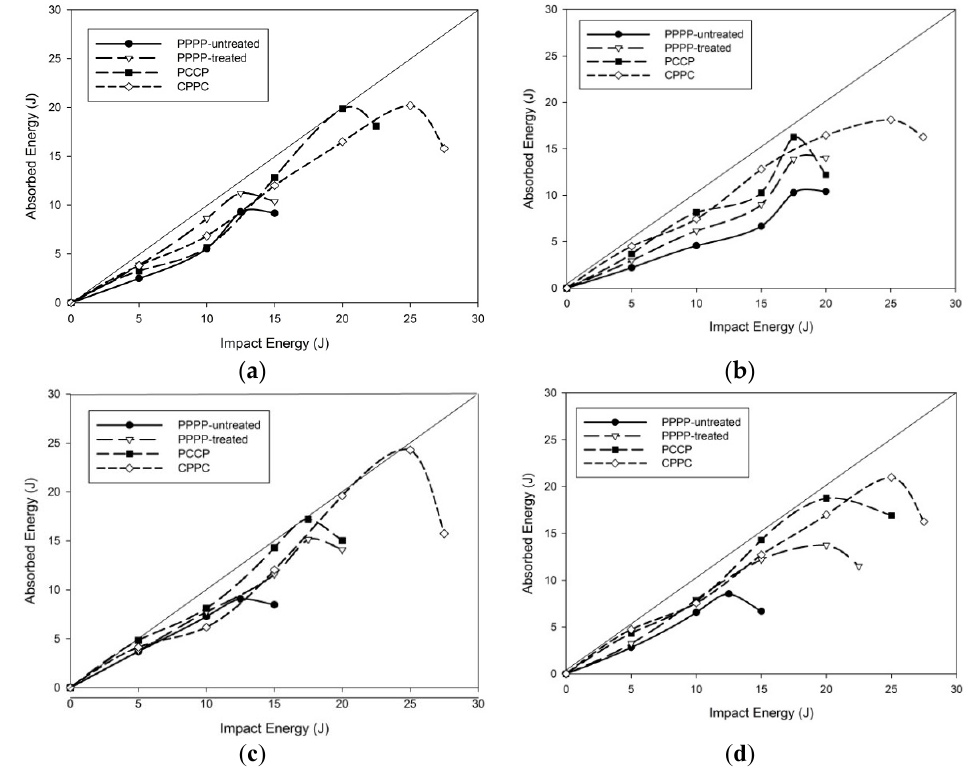
Figure 15. Energy profiling diagram of the hybrid laminates at ply orientations of ( a ) [0°/90°] 8 , ( b ) [±45°] 8 , ( c ) [±45° 2 , 0° / 90° 2 ] s , and ( d ) [0° / 90° 2 , ±45° 2 ] s . ( b ) [ ± 45 ◦ ] 8 , ( c ) [ ± 45 ◦ 2 , 0 ◦ /90 ◦ 2 ] s , and ( d ) [0 ◦ /90 ◦ 2 , ± 45 ◦ 2 ] s